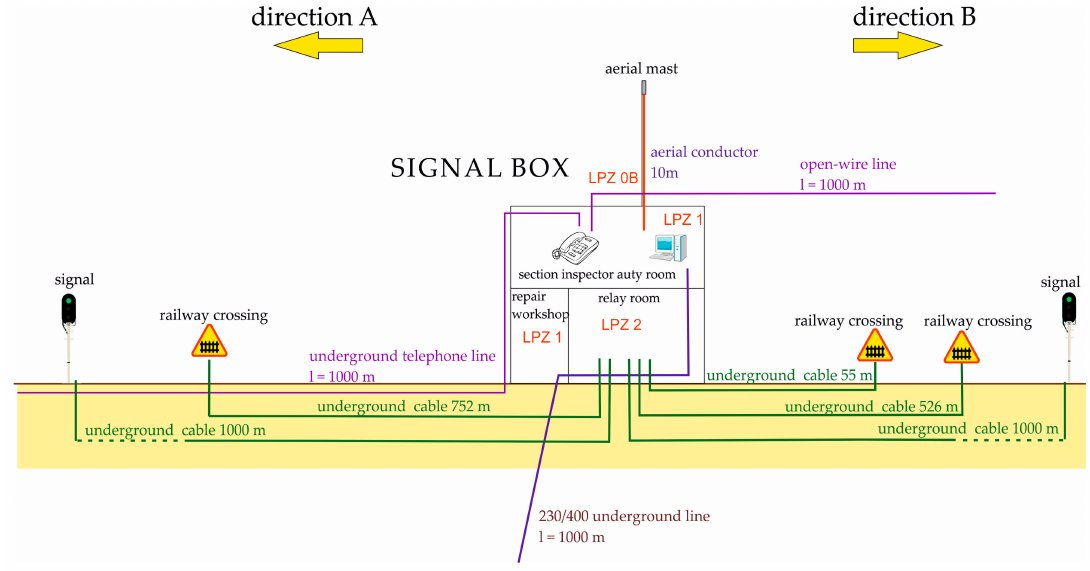
Figure 3. Model of St building with connected devices [1]. LPZ: lighting protection